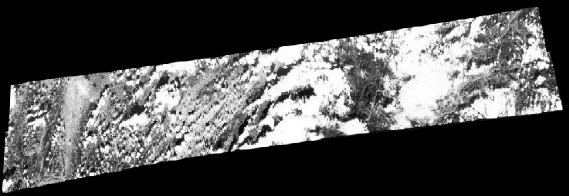
Figure 7. Double scene image mosaicking of DS1105- 2264DF039 and DS1105-2264DF039